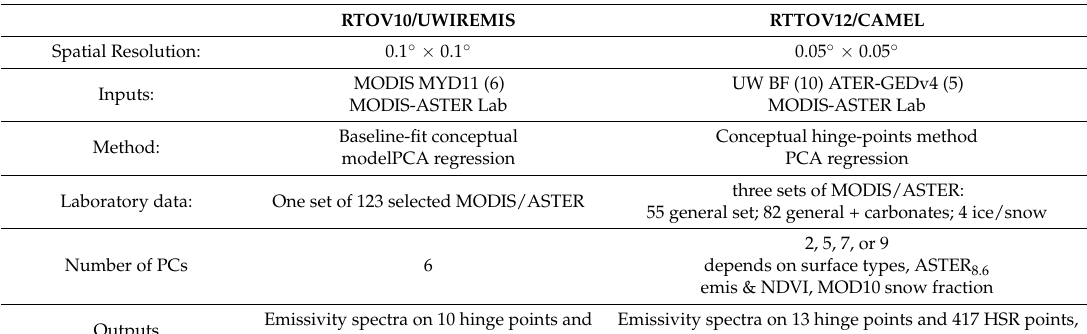
Table 4. Summary of comparison between the RTTOV10/UWIREMIS and RTTOV12/CAMEL emissivity databases.